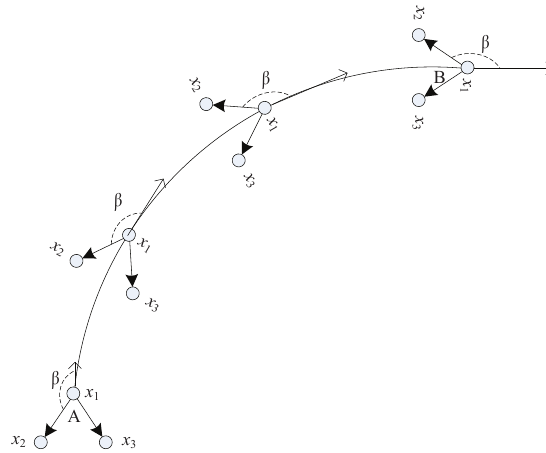
Figure 3. A formation moves in a constant turning (CT) from points A to B . To keep a fixed formation, the angle between two vectors: the vector for the velocity of parent node x 1 and the vector of positions between x 1 and x 2 should keep a fixed value β